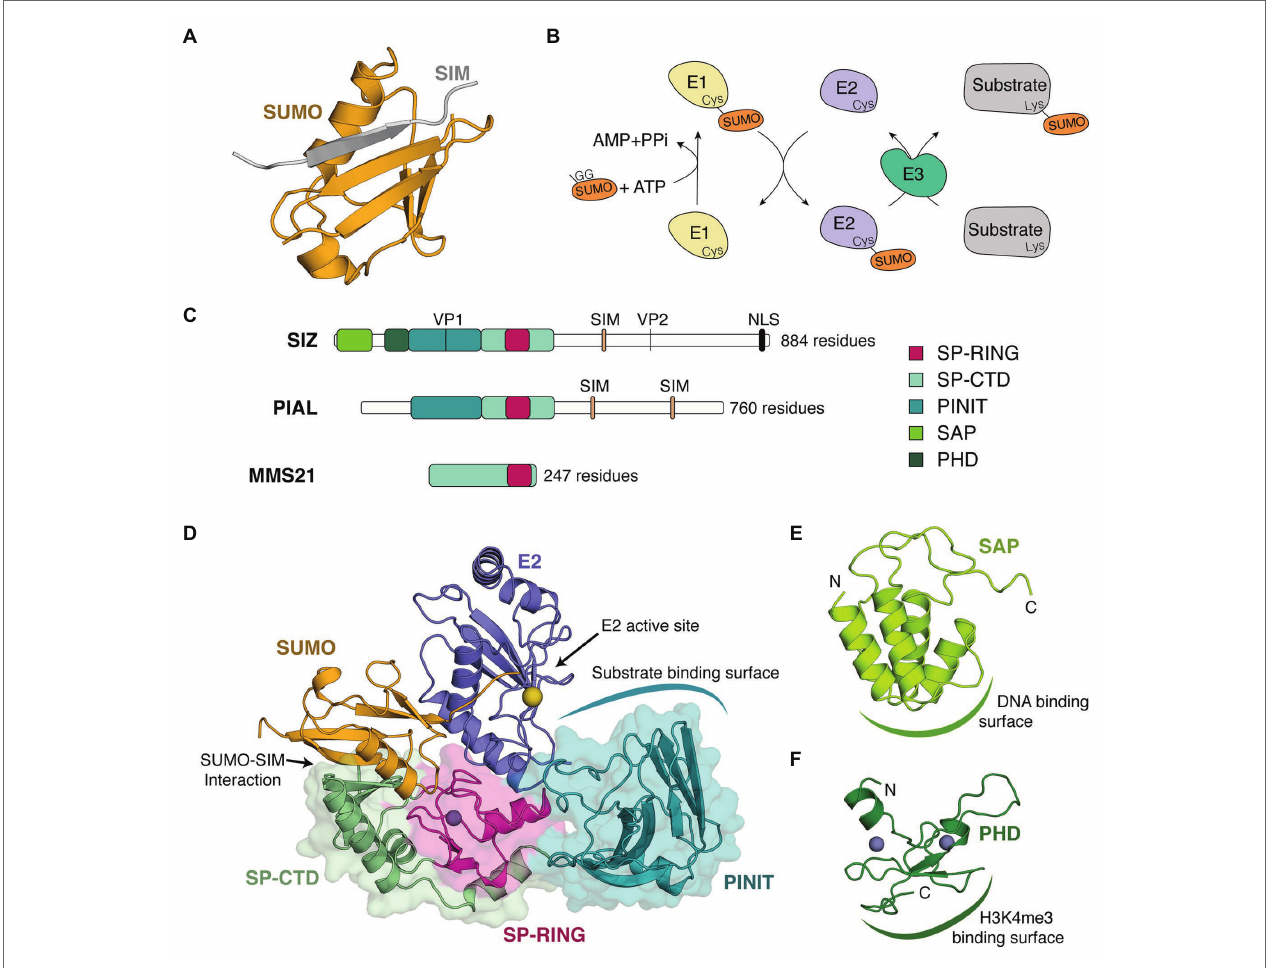
FIGURE 1 | Plant SUMO E3 ligases, organizations, and structures. (A) Structure of a complex between SUMO and a SUMO interacting motif (SIM). In this structure, the β -sheet of SUMO (orange) from Saccharomyces cerevisiae is complemented by a β strand (gray) of RANBP2 (PDB 1Z5S) in an antiparallel orientation. (B) SUMOylation conjugation cascade where E1, E2, and E3, respectively, designate an E1-conjugating enzyme (pale yellow), an E2-conjugation enzyme (purple), and an E3-ligase (green). GG represents the di-glycine motif located at the C-terminal end of SUMO. (C) Schematic representation of the three types of SUMO E3 ligases found in plants. As representative members of each class, we chose Arabidopsis thaliana SIZ1 (top), PIAL2 (middle), and MMS21 (bottom). Domains are illustrated by boxes, whereas motifs are depicted by vertical lines. Domains present in plant SUMO E3 ligases include the SAF-A/B, Acinus, and PIAS (SAP) domain, the plant homeodomain (PHD), the PINIT domain, and the SP-RING domain. Historically, the SIM of SIZ1 has been referred to as the SXS motif (Minty et al., 2000). Although a SXS motif is well conserved in plants, this motif is actually part of a C-terminal extension of the SIM (Park et al., 2011). Studies in other systems have indeed shown that the serine residues can be targeted by phosphorylation and that this phosphorylation increases the strength of SUMO-SIM interaction by promoting interactions with a basic patch on SUMO (Chang et al., 2011; Anamika and Spyracopoulos, 2015; Cappadocia et al., 2015a). (D) Crystal structure of a SUMO~E2/ SIZ1 complex from S. cerevisiae in a configuration prompt for catalysis (PDB 5JNE). The different domains of SIZ1 are in cartoon and surface representation and are colored as in (C) . E2 and SUMO are in cartoon representation in blue and orange, respectively. A gray sphere represents a zinc ion that stabilizes the SP-RING domain, whereas a yellow sphere represents the position of the catalytic cystine within the E2 active site. (E) Solution structure of the SAP domain of Oryza sativa (PDB 2RNO). The domain is in cartoon representation and is colored as in (C) . Domain termini are indicated as « N » and « C ». (F) Solution structure of the PHD domain of O. sativa (PDB 2RSD). The domain is in cartoon representation and is colored as in (C) . Domain termini are indicated as « N » and « C